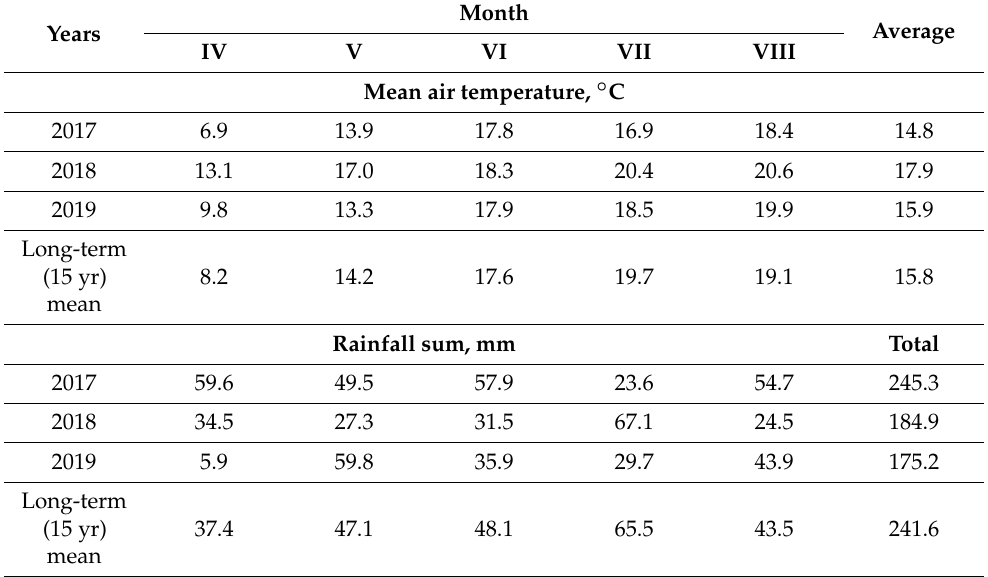
Table 1. Weather conditions in the growing season of spring wheat according to the Zawady Meteorological